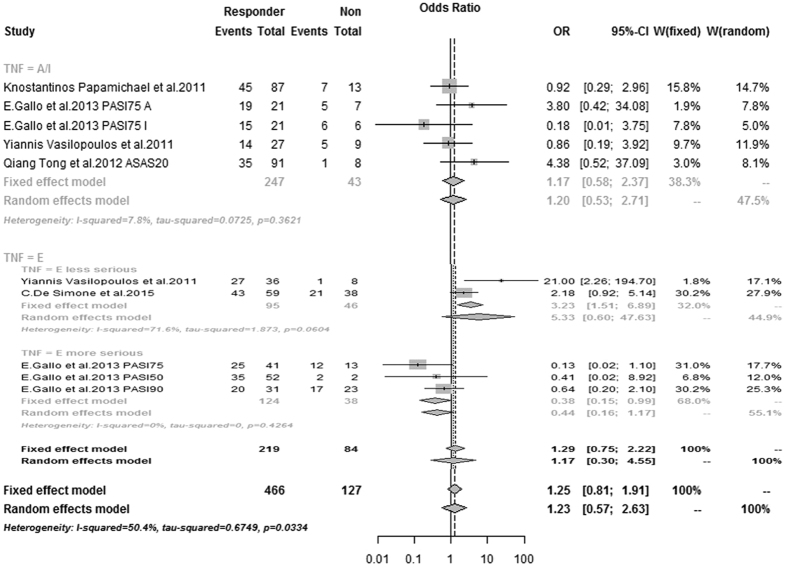
Odds ratios (ORs) and 95% confidence intervals (CI) from each study testing association of −857 C > T TNFα polymorphism and response to TNF blockers in SpA patients.If p-value < 0.1 we used the result of random effects model. Otherwise, a fixed effect model was used. A/I: adalimumab/infliximab, events: number of subjects with the common allele observed, Res: responder, Non: nonresponder.